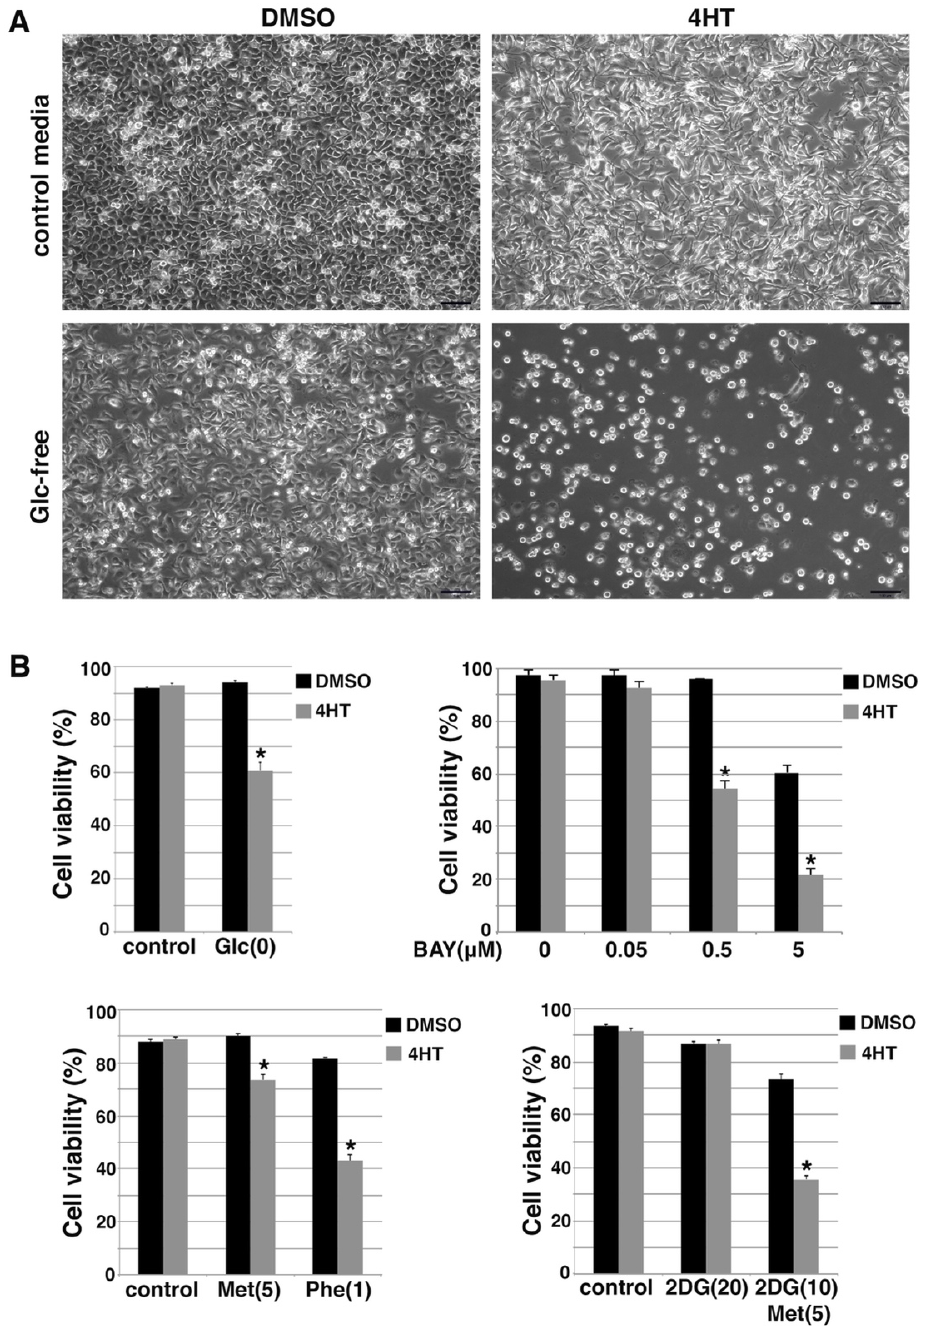
Figure 6. Snail-driven EMT sensitizes DCIS-Snai1-ER cells to energy stress conditions. ( A ) DCIS-Snai1-ER cells were treated with DMSO or 4HT for 2 days, then cultured in normal or glucose (Glc)-free media for 1 day. ( B ) Trypan blue cell viability assays. DCIS-Snai1-ER cells were treated with DMSO (vehicle) or 4HT for 2 days, followed by 1-day treatment with glucose (Glc) deprivation, glucose transporter inhibitor BAY-876 (Bay), metformin (Met, 5mM) or phenformin (Phe, 1 mM), or 2DG (10, 20 mM) ± metformin (5 mM). Cell viability was calculated as the number of viable cells divided by the total number of cells. Data shown as mean ± S.D. * p < 0.01.